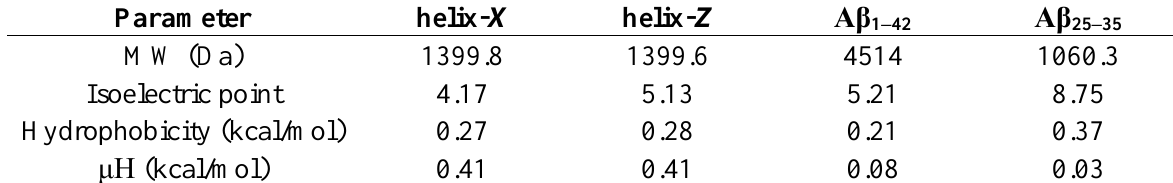
Table 1. Physicochemical parameters of peptides.